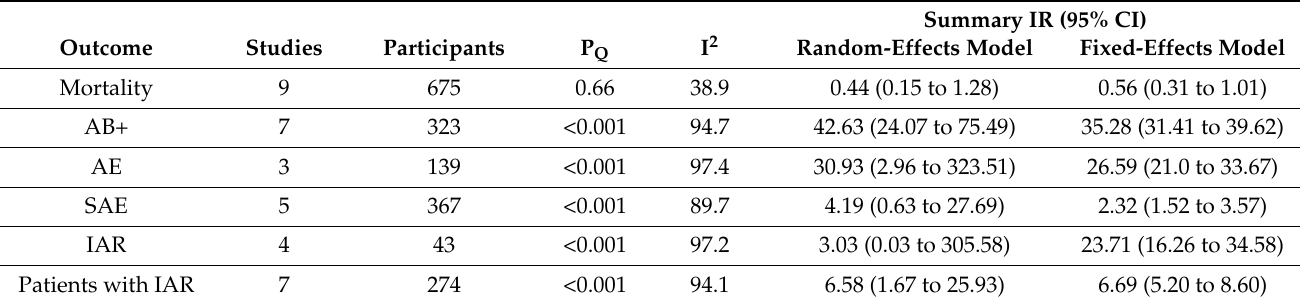
Figure 7. Evaluation of the time on ventilation (h) of patients with late-onset Pompe disease on enzyme replacement therapy with alglucosidase alfa. Weights are inverse-variance weights and are proportional to the contribution of each study to the summary estimate. I² is the fraction of variance that is due to statistical heterogeneity and not chance. Tau² denotes the between-study variance. Table 4. Summary estimates for incidence of safety outcomes of enzyme replacement therapy for patients with late-onset Pompe